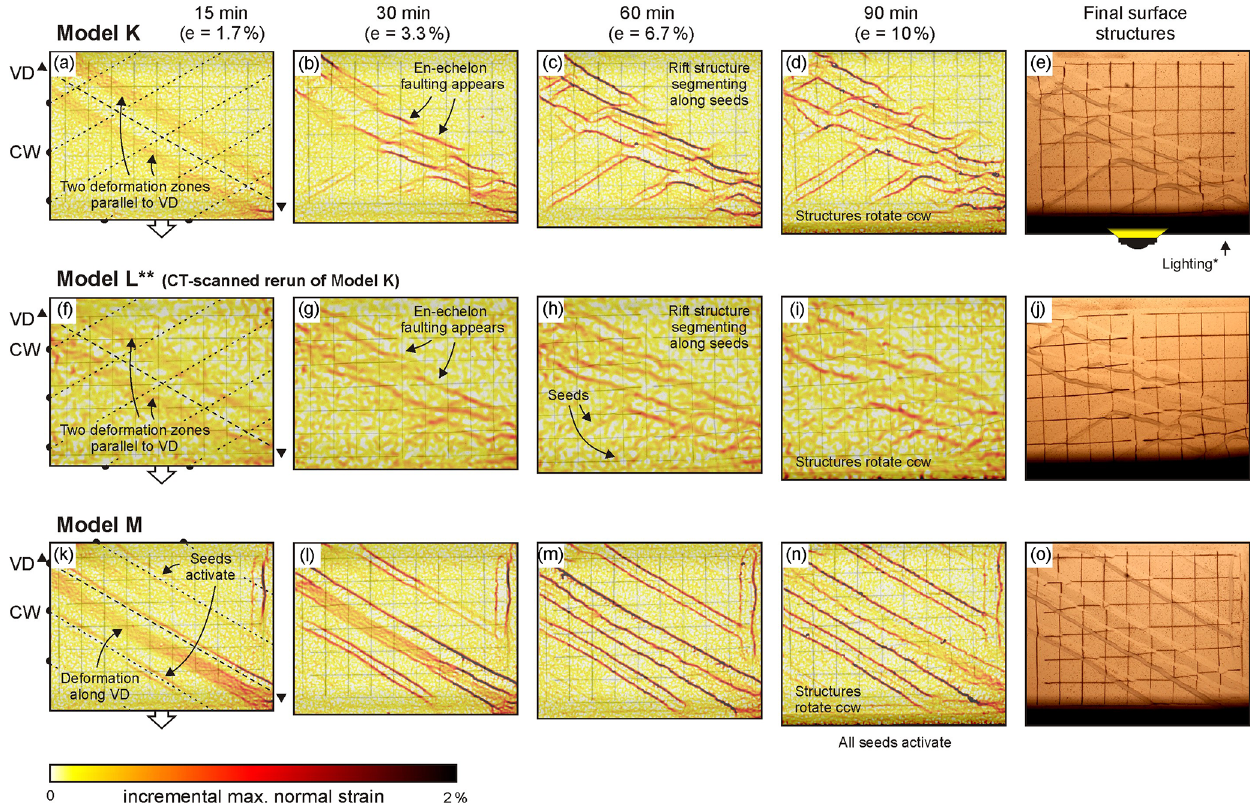
Figure 7. Incremental maximum normal strain maps of models K–M from Sub-series 2.2 (with 30 ◦ oblique VD and oblique seeds in the brittle cover) obtained through PIV analysis, taken as a proxy of fault activity. The increments for PIV analysis were 1min, i.e. every 0.33mm of extension. The original model map-view pictures are visible in the background. The right-hand column depicts the model surface at the end of each experiment. Note that Model M includes a crustal weakness (seed) above and parallel to the VD. VD: velocity discontinuity. CW: (simulated) crustal weakness. ccw: counter-clockwise. ∗ Shadows cast by one-sided lighting allowing a better visualization of the final surface structures. ∗∗ Due to technical issues, the PIV analysis of Model L is less